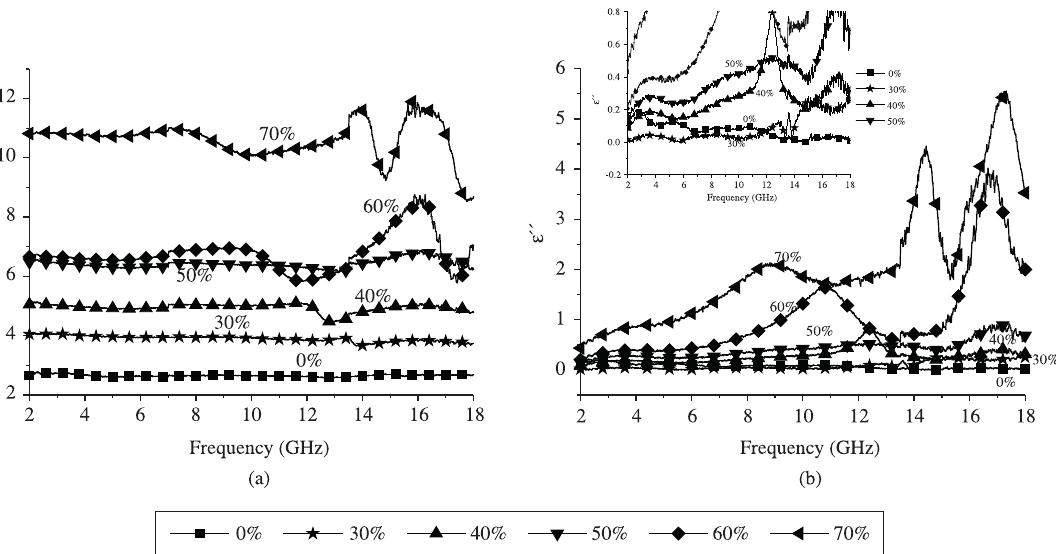
Figure 4. (a) Real and (b) imaginary dielectric permittivity curves for RAM based on MnZn ferrite (0, 30, 40, 50, 60 and 70% (w/w)) in function of the frequency.